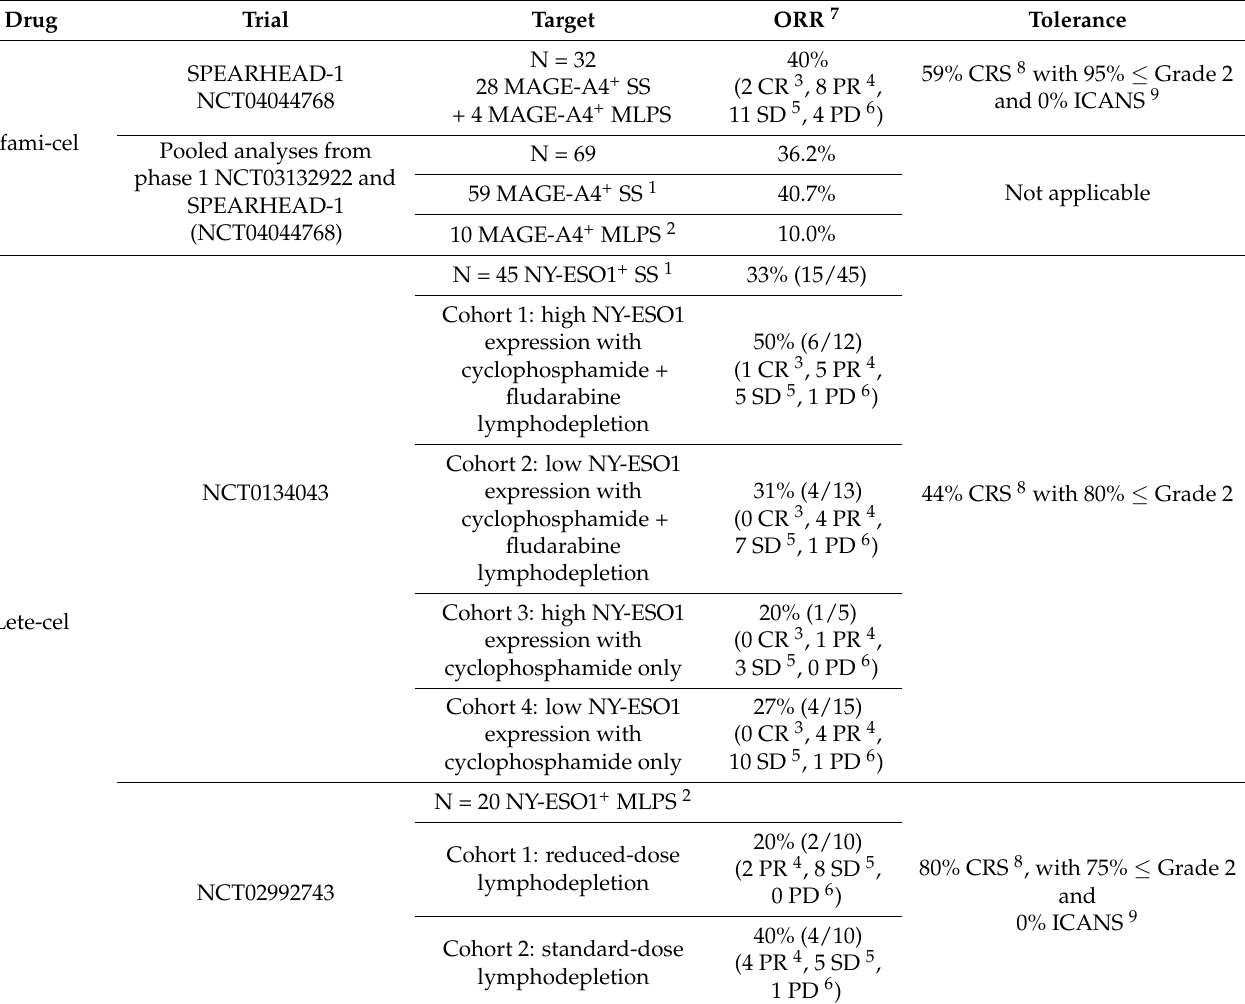
Table 3. Responses to TCR T cells in MAGE-A4 + and NY-ESO 1 SS and MLPS: preliminary